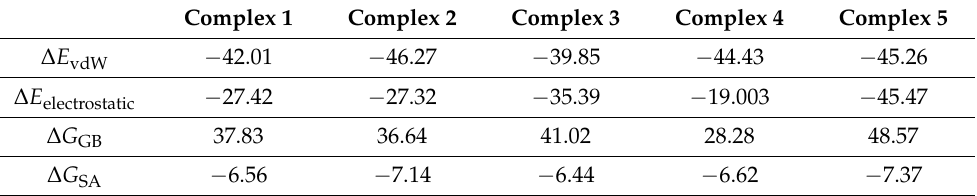
Table 4. Energy contribution to the binding free energy (kcal/mol) for top five potential hits obtained by MM-GBSA